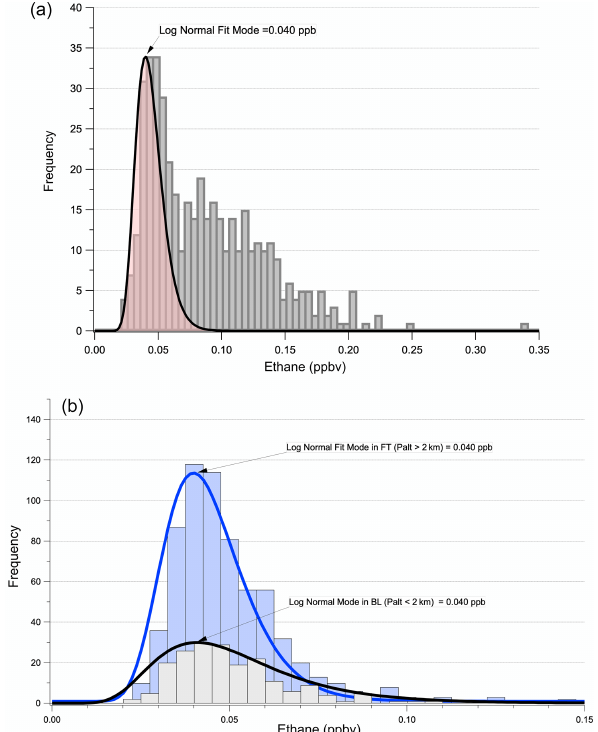
Figure 8. (a) Precision histogram of all zero background measure- ments for the third field deployment phase (3–16 October 2017); bin width: 0.005ppbv. (b) Precision histograms of zero air background measurements in the PBL and in FT acquired during the spring 2018 fourth field deployment phase using a bin width of 0.005ppbv.